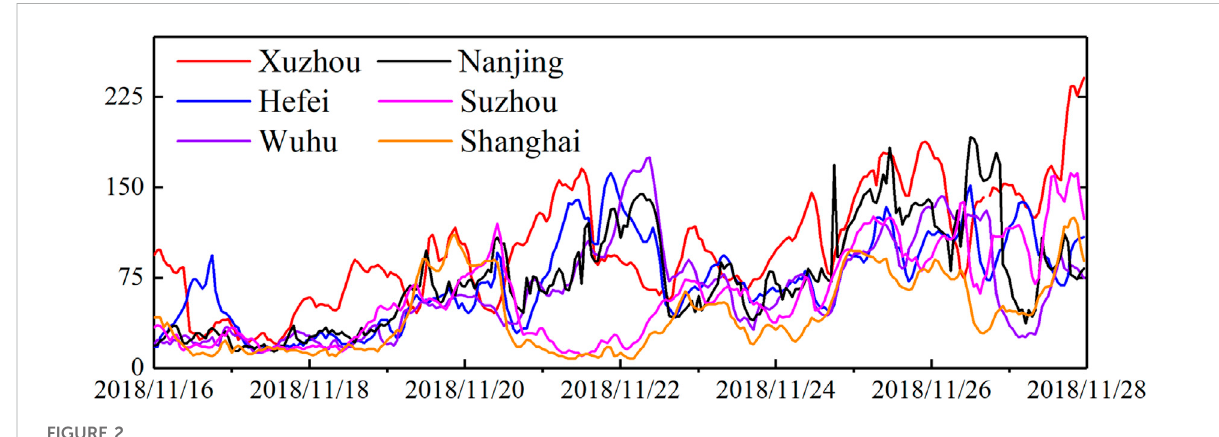
FIGURE 2 Time series of PM 2.5 in major cities in YRD during the study